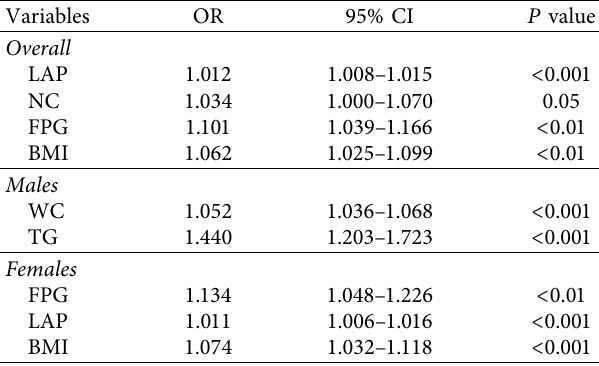
Table 3: Logistic regression analysis of factors associated with